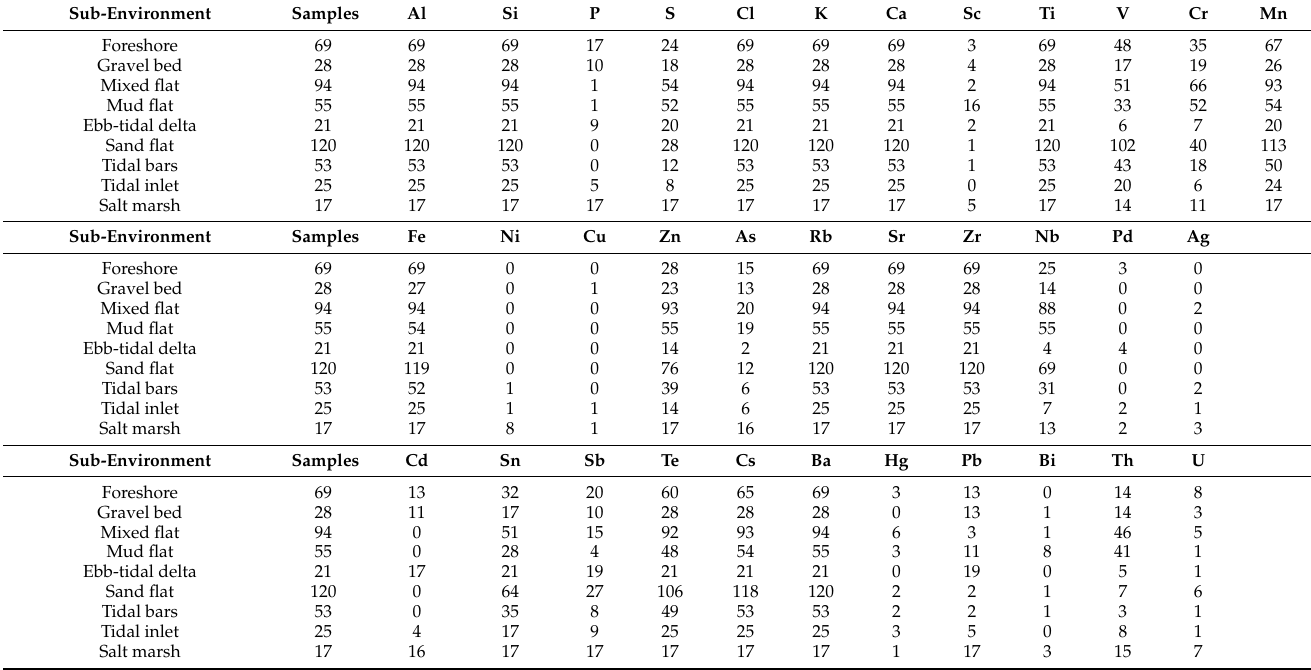
Table 2. Summary of geochemical elements identified by the handheld pXRF tool and number of samples for which the element is above the limit of